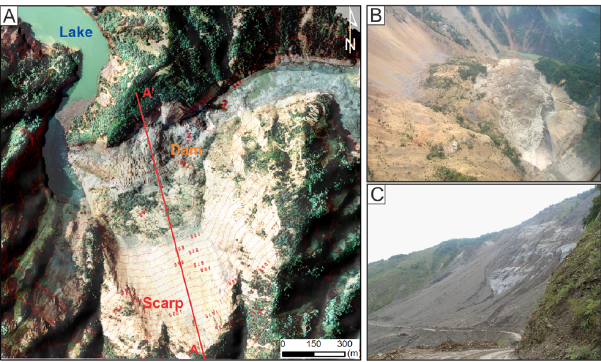
Fig. 2. (A) Aerial photo of the Tangjiashan landslide dam (source: Ministry of Land and Resources); (B) photo of the dam body; (C) photo of the landslide back